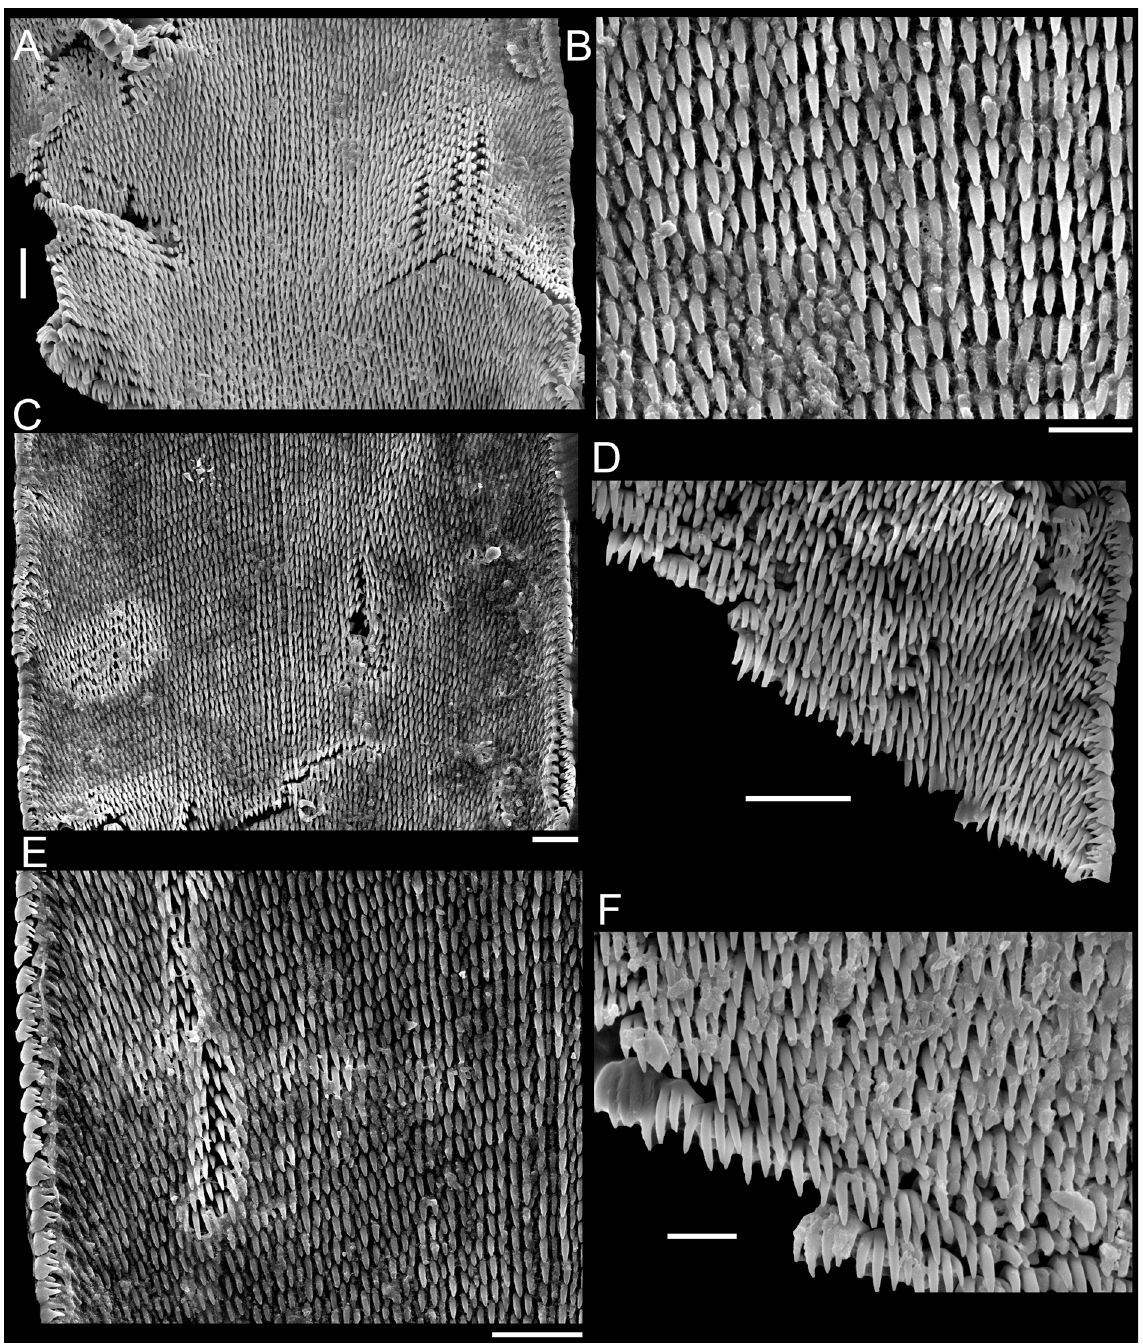
Fig. 31. “ Inella ” harryleei Rolán & Fernández-Garcés, 2008, radula. A–F . FLMNH 450495. Scale bars: A, C–E = 10 µm; B, F = 5